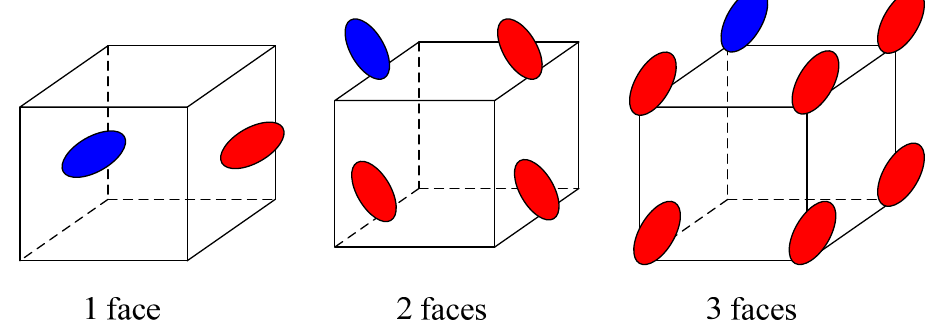
Figure 6. The periodic images when the ellipsoid intersect with different cell faces.